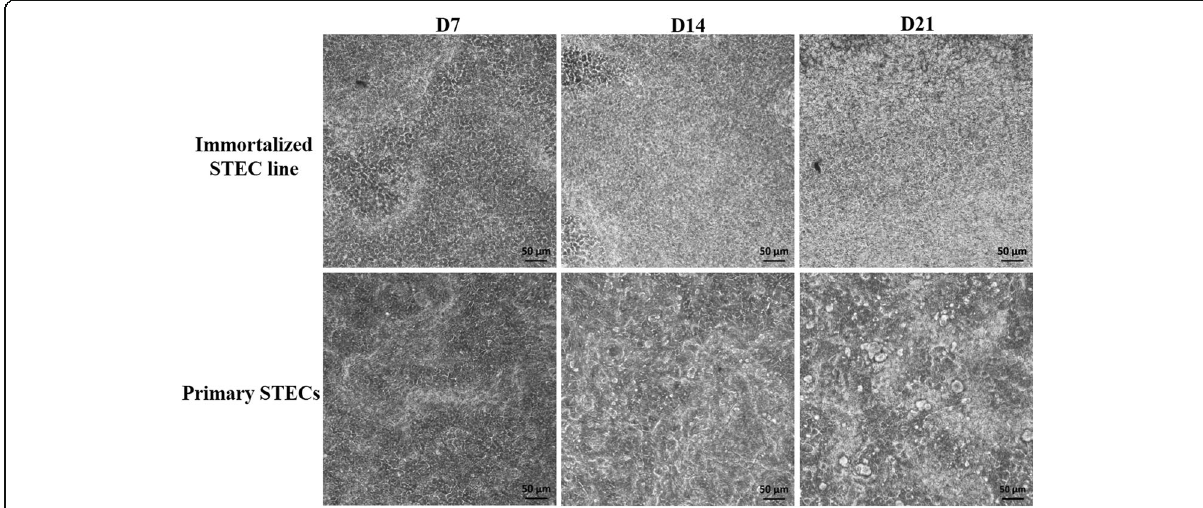
Fig. 1 Development of immortalized STEC line and primary STECs cultured under Ali conditions over 21 days. The immortalized STEC line and primary STECs were immersed in media, and they grew into a confluent monolayer within 2 days. At this time, the apical medium was then discarded to create Ali conditions. Cellular morphological changes at different time points (D7, D14, and D21) were observed by